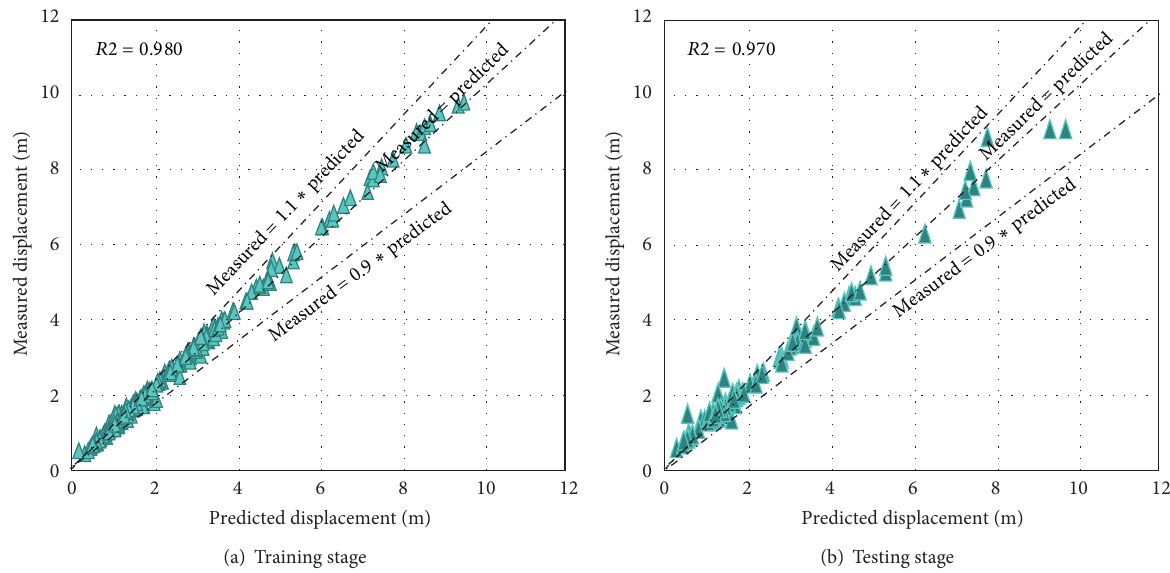
Figure 34: Comparison between NEFLAS and measured lateral spread, Niigata, Japan. (a) Training stage and (b) testing stage.